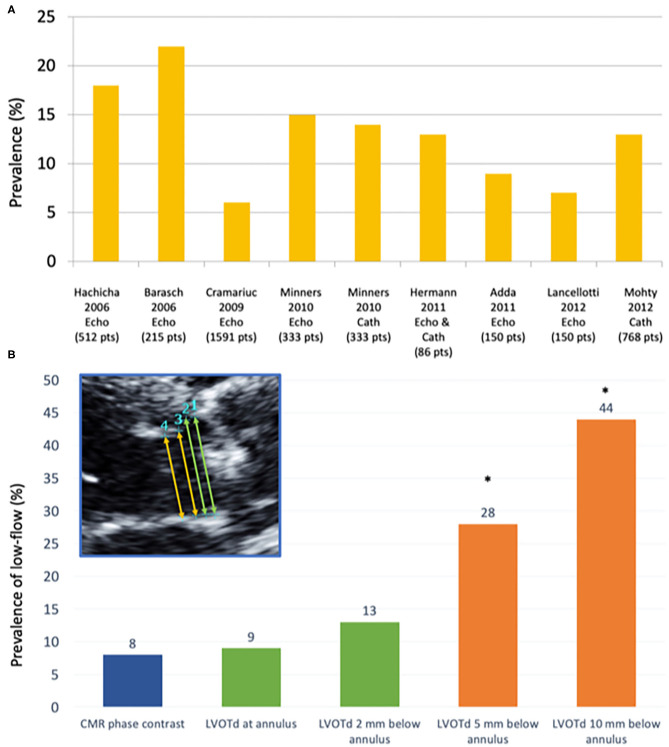
Prevalence of low flow according to different studies and measurement techniques. (A) Prevalence of paradoxical low-flow severe AS (i.e., AVA <1.0 cm2; MG <40 mmHg, LVEF>50%; SVi <35 mL/m2) according to different studies using echocardiography (Echo) and/or invasive catheterization (Cath). (B) Prevalence of low-flow state (stroke volume index ≤ 35 ml/m2) according to different measurement sites of the LVOT: (1) at the hinge points of the aortic valve leaflets (annular level); (2) very close to (i.e., 2 mm below) the annular level; (3) 5 mm below the annular level; and (4) 10 mm below the annular level, as compared to the referent standard (phase-contrast CMR) [modified from JASE (16)]. CMR, Cardiovascular magnetic resonance; LVOTd, left ventricular outflow tract diameter. *p < 0.01 as compared to CMR-PC (referent method).